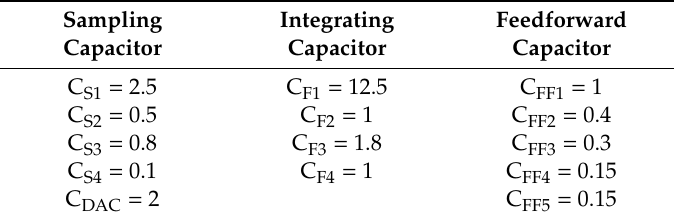
Table 2. Capacitor values used in the DSM (units are in